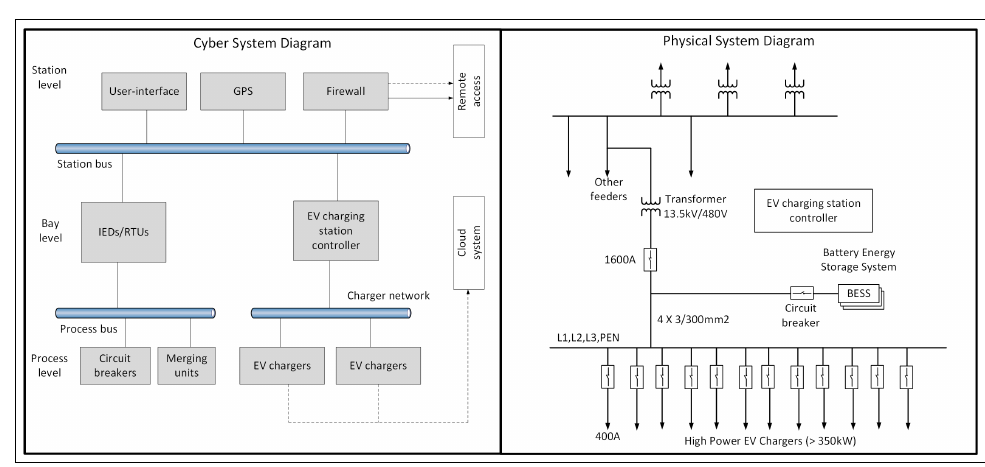
Figure 1. Cyberphysical system diagram of EV charging station connected